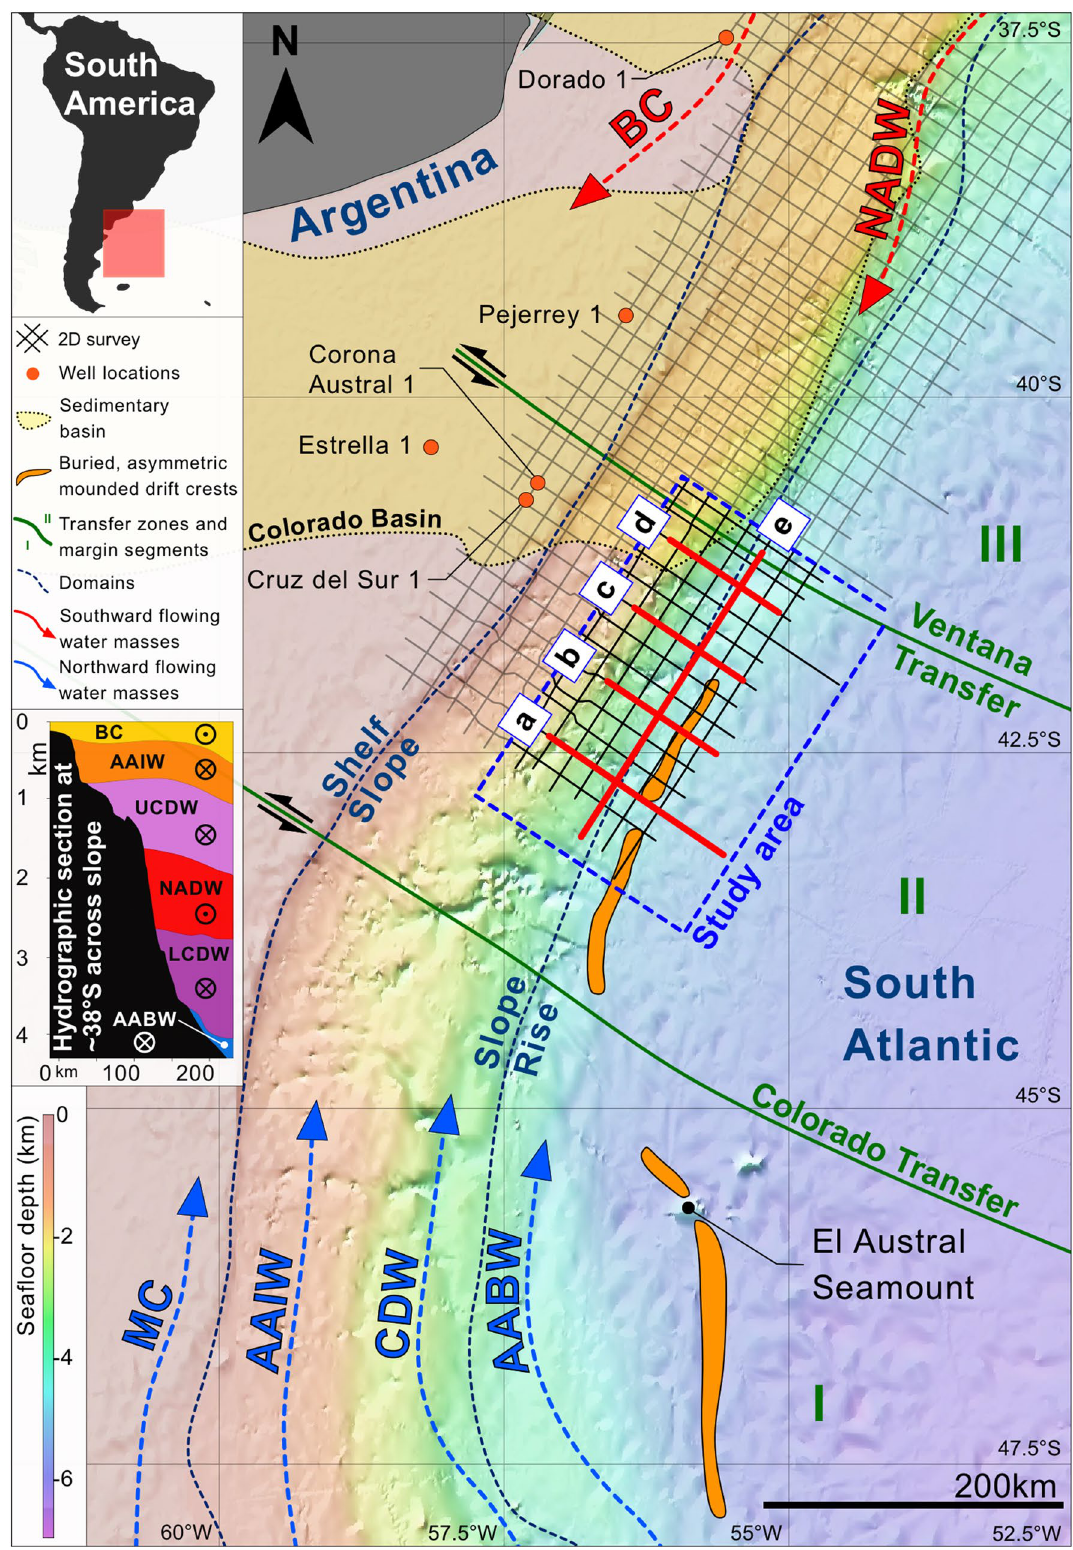
Figure 1. Regional bathymetric map from Tozer et al. (2019) 16 showing the study area, domains, dataset, seismic profile figures ( a – e ), and buried drift crests. Arrows indicate flow directions of surface (BC = Brazil Current, MC = Malvinas Current), intermediate (AAIW = Antarctic Intermediate Water), deep (NADW = North Atlantic Deep Water, CDW = Circumpolar Deep Water), and bottom (AABW = Antarctic Bottom Water) waters 17 . Hydrographic section adapted from Hernández-Molina et al. (2010) 18 after Piola and Matano et al. (2001) 19 ; sedimentary basins, rift segments and fracture zones adapted from Franke et al. (2007) 12 . The figure was generated using Pixelmator Pro 2.1.3 Coral (https:// www. pixel mator. com/